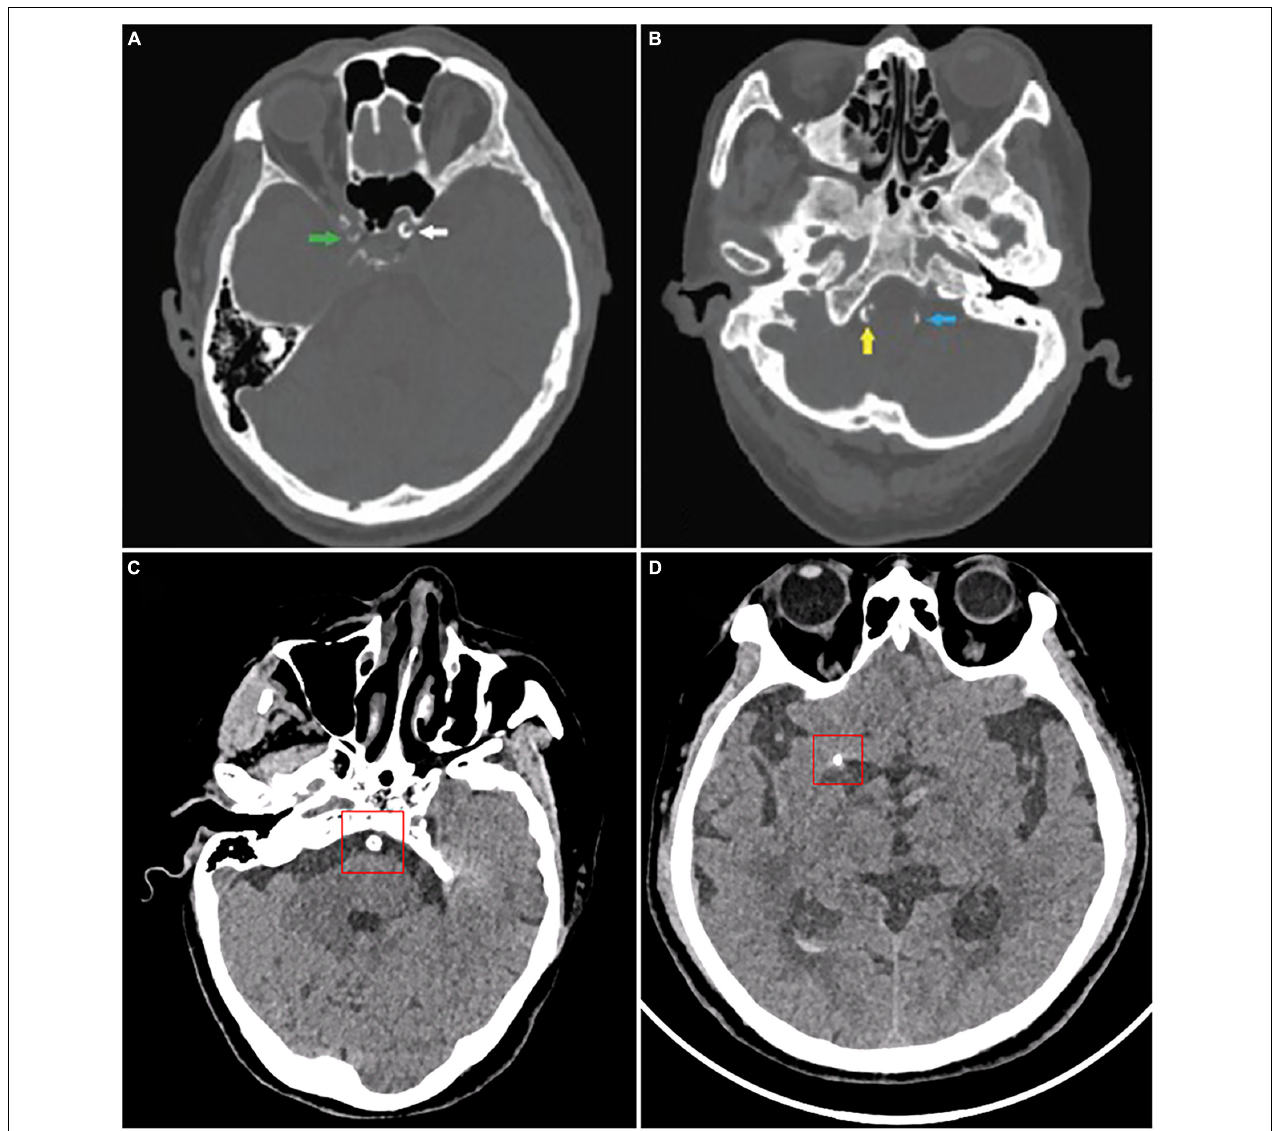
FIGURE 2 | CT images of intracranial artery calcification. According to Babiarz’s method, calcifications were graded as follows: (A) Calcifications in the right internal carotid artery (green), 3 for extent and 2 for thickness; left internal carotid artery (white), 4 for extent and 3 for thickness. (B) Calcifications in the right vertebral artery (yellow), 3 for extent and 3 for thickness; left vertebral artery (blue), 2 for extent and 2 for thickness. According to Woodcock scoring, calcifications were graded as follows: (C) Calcifications in the basilar artery, severe (thick, continuous). (D) Calcifications in the middle cerebral artery calcification, moderate (thick, discontinuous). (A,B) Were from Wu et al.